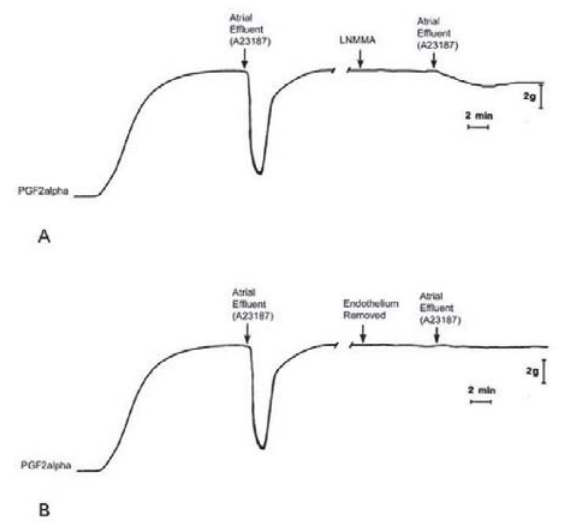
Fig. 2 - Representative recording of change in contraction of canine coronary artery ring with endothelium superfused with effuent from atrial tubes infused with A23187. Relaxation was inhibit when the ring was superfused with L-NMMA (A) and when the endothelium was removed